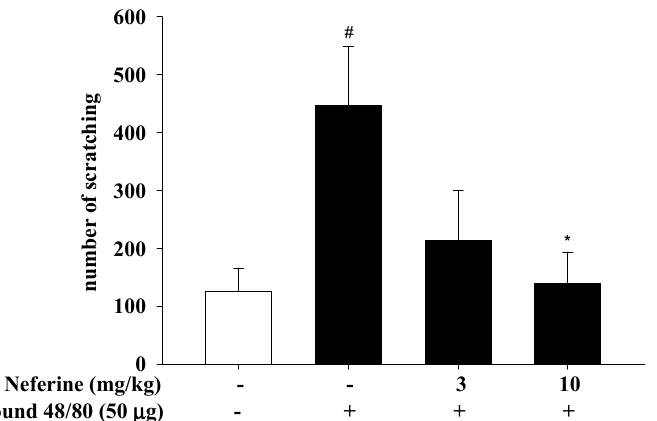
Figure 9. The effects of neferine for treatment of 5 days on compound 48/80-induced scratching behavior in BALB/c mice. Each column and vertical bar show the mean ± SEM from the three independent experiments. #, * p < 0.05 compared with the control group and compound 48/80 alone group (Student’s t -test).